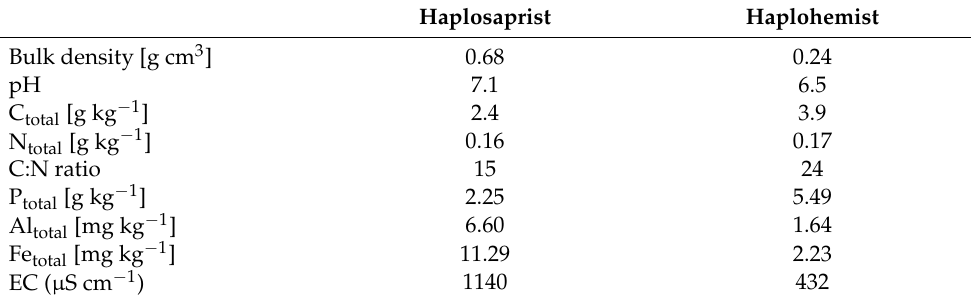
Table 1. Initial soil properties (dry weight basis).